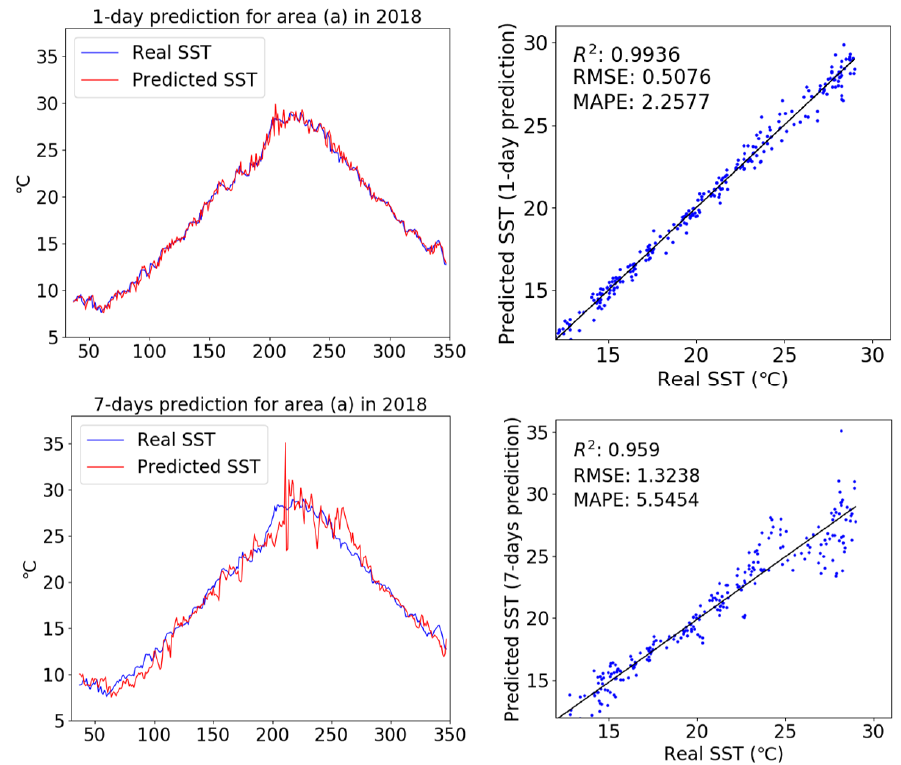
Figure 9. Comparison of predicted and real SST data, with scatter diagrams, for 1-day and 7-days prediction intervals using the SST dataset as input.